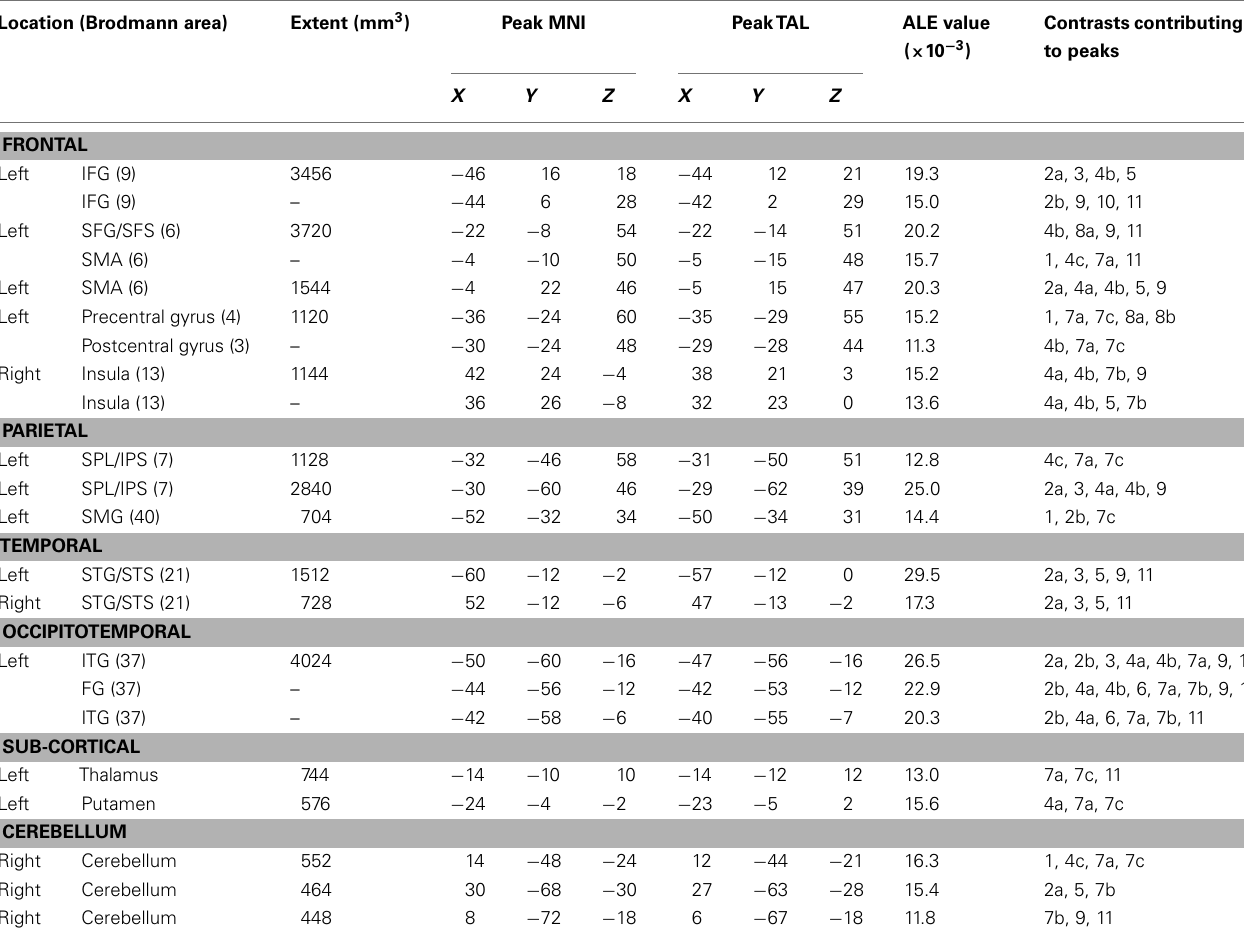
Table 2 | Results for the all-contrasts written production meta-analysis. Location (Brodmann